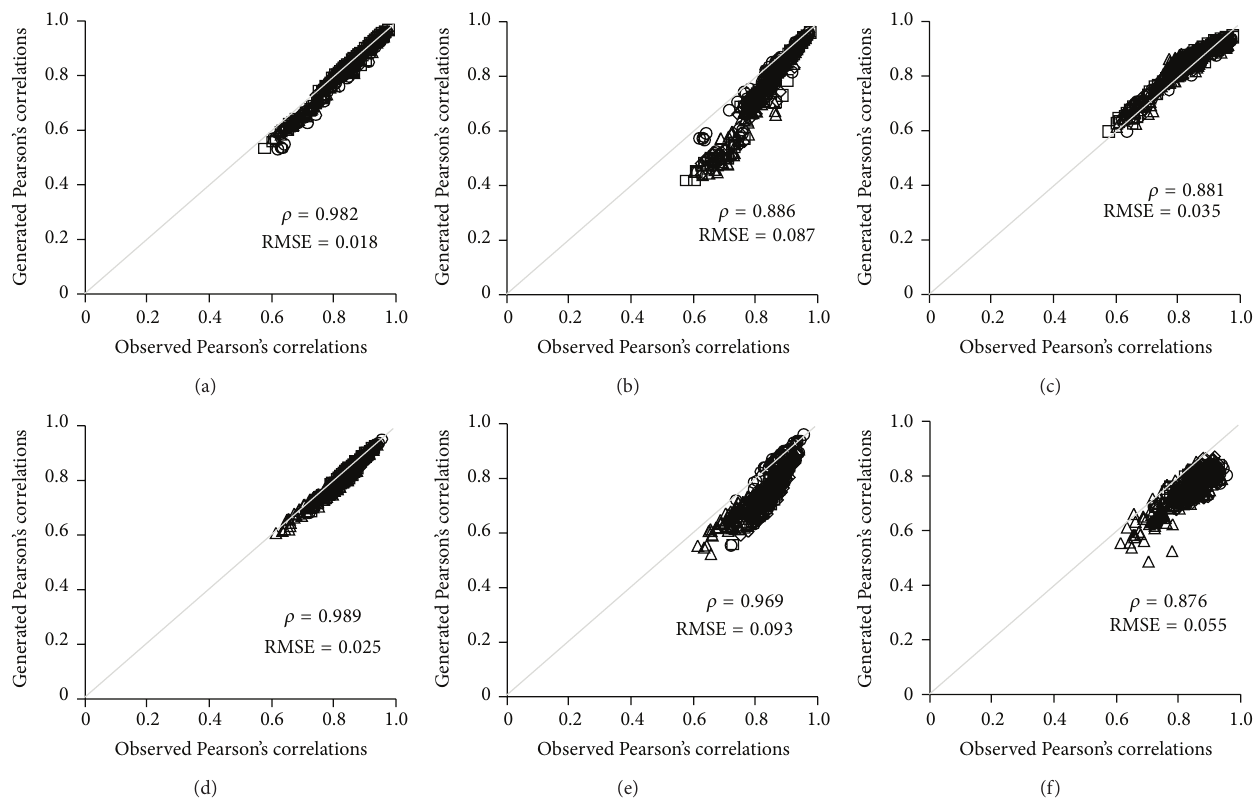
Figure 4: Comparison between observed and generated correlations of daily maximum temperatures ((a), (b), (c)) and minimum temperatures ((d), (e), (f)) among all pairs of weather stations for each month. ((a), (d)) first model, ((b), (e)) second model, and ((c), (f)) third model. ( I ) December-January-February, ( ◻ ) March-April-May, ( Δ ) June-July-August, and ( ◊ )